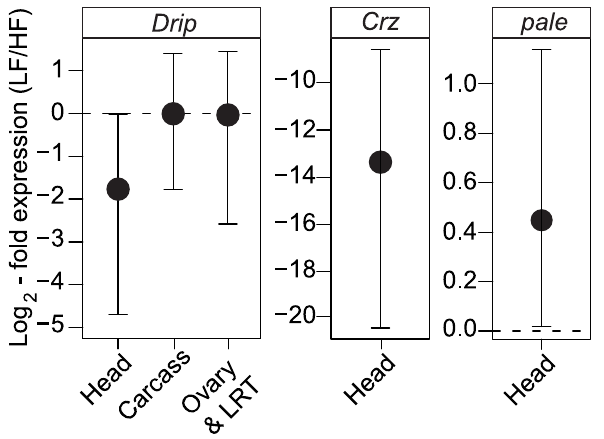
Figure 3. Tissue-specific expression of Drip , Crz , and pale between the different RIL alleles. The y -axis represents fold change in Drip expression between low- and high-fecundity alleles, normalized to differences in Rpl32 . Error bars represent 95% CI based on permutations; see text for details. The horizontal, dashed line represent the null hypothesis of no change in gene expression.